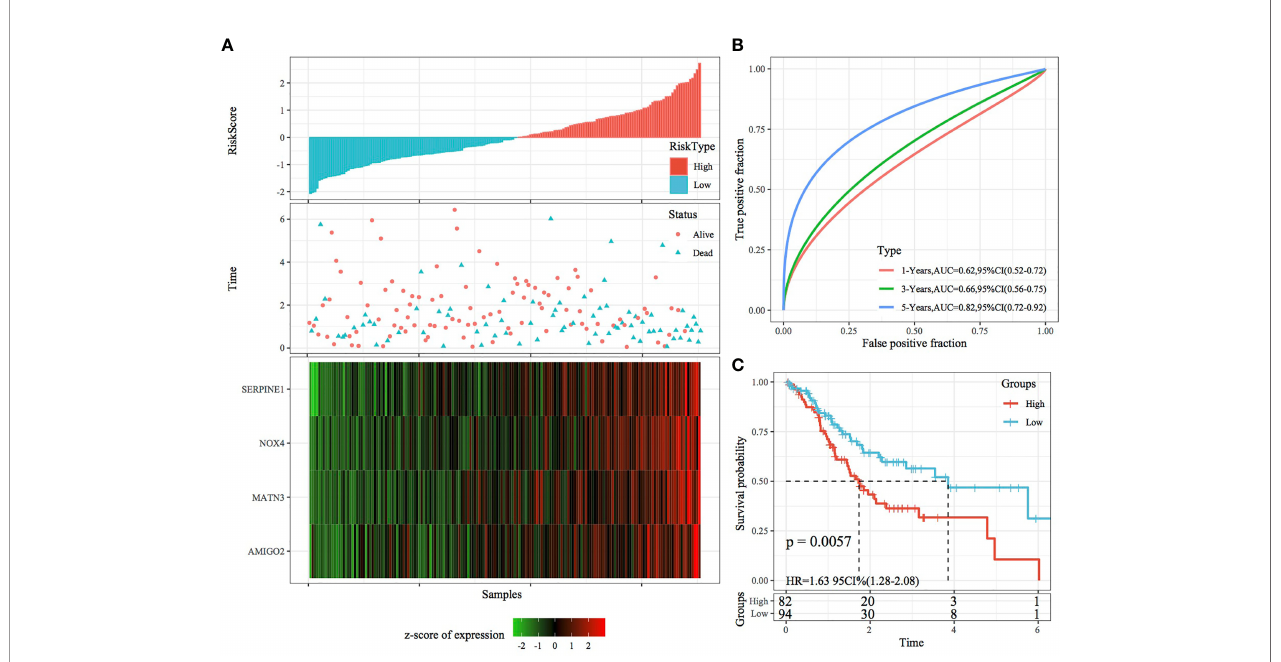
FIGURE 6 | Validation of the four-gene signature in the training set. (A) RiskScore, survival status and the expression of four genes in TCGA training set. (B) ROC curve and AUC of the four-gene signature. (C) KM curve demonstrating survival predicted by the four-gene signature in the training set.